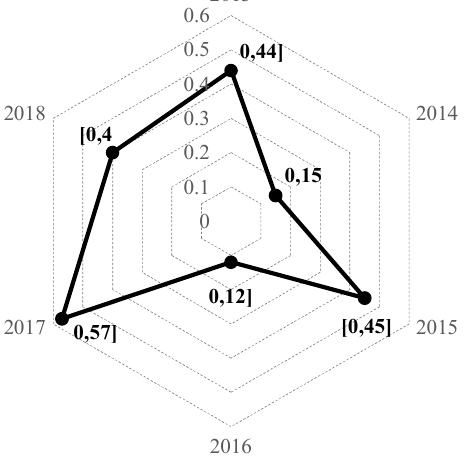
Fig. 3. Dynamics of the integrated taxonomic indicator of the development level of PJSC «NKMZ» during 2013-2018